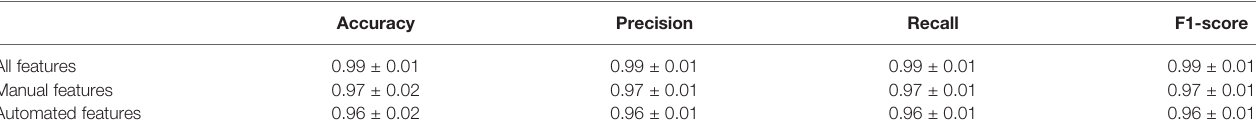
TABLE 2 | Diagnose scenario: K-nearest neighbor algorithm ’ s accuracy, precision, recall, and F1 score for classifying 106 calves as sick ( s (+) ) or negative ( H (-) ) for bovine respiratory disease. Accuracy Precision Recall F1-score